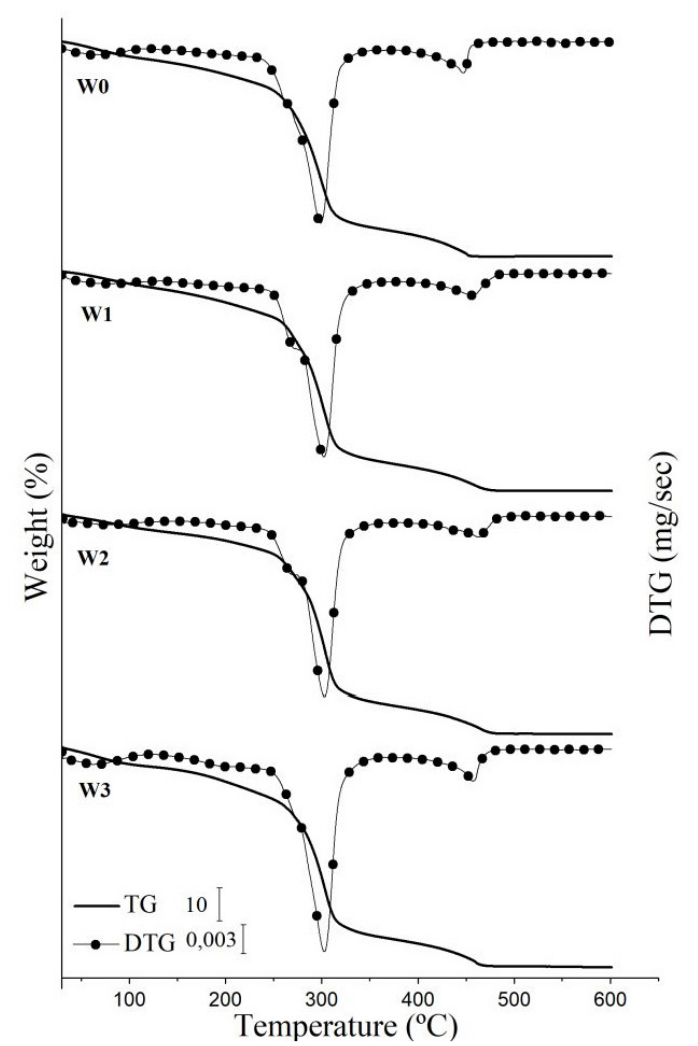
Figure 3. TGA curves and DTG of regular and waxy maize starch films. Note: W0 = waxy starch film with 0% nanocellulose; W1 = waxy starch film with 0.5% nanocellulose; W2 = waxy starch film with 1% nanocellulose; W3 = waxy starch film with 1.5%